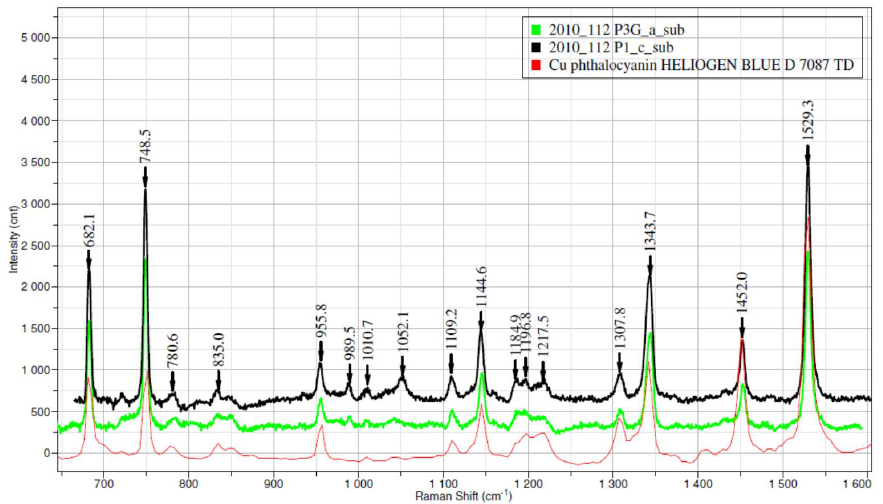
Figure 4. Raman Spectra for two blue paint samples with reference (in red) Heliogen Blue (copper phthalocyanine blue).